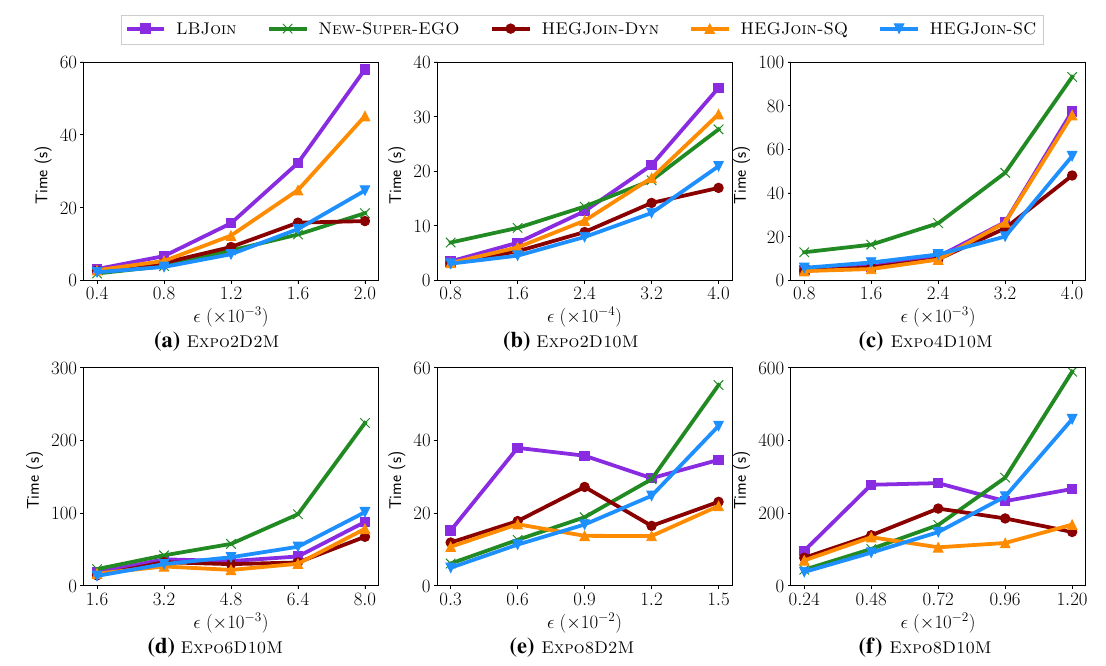
Fig. 10 Response time of HEGJ oin -d yn , HEGJ oin -SQ , HEGJ oin - SC , LBJ oin , and n Ew -S upEr -EGo on a Expo2D2M , b Expo2D10M , c Expo4D10M , d Expo6D10M , e Expo8D2M , and f Expo8D10M . S